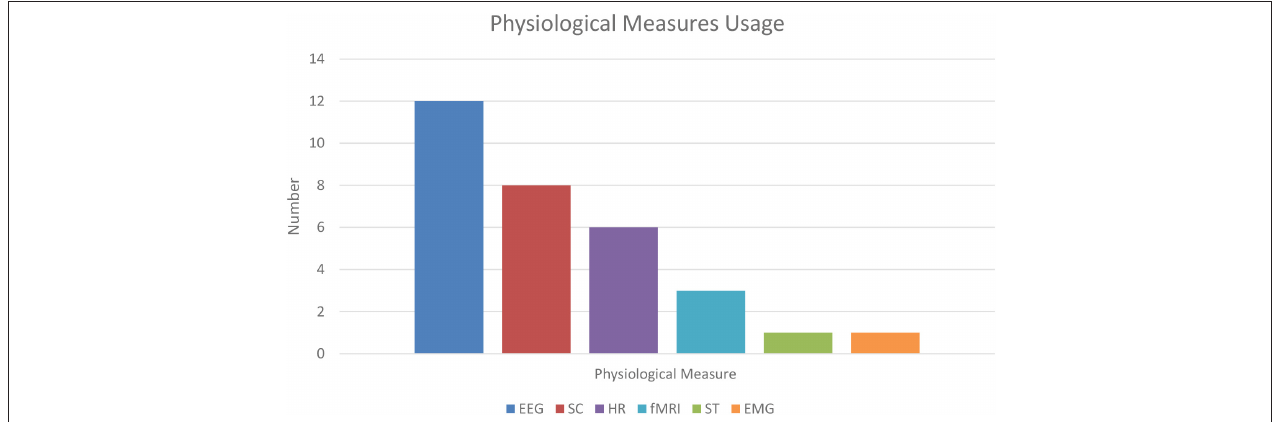
FIGURE 3 | Physiological measures in the reviewed studies. SC, skin conductance; EEG, electroencephalogram; HR, heart rate; fMRI, functional magnetic resonance imaging; ST, skin temperature; EMG, electromyography. As noted from the chart, EEG is the most commonly used physiological measure, followed by